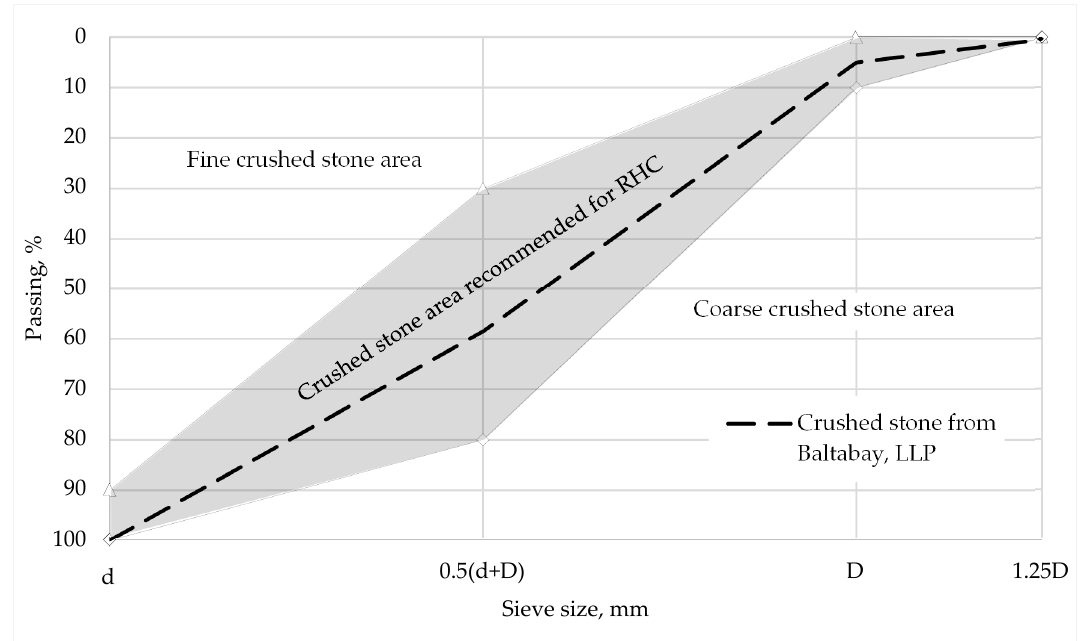
Figure 2. Sieve analysis grading curve for coarse aggregate [22].